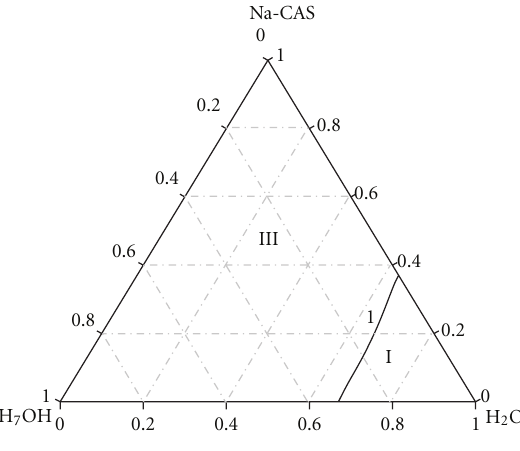
Figure 11: Solubility diagram of Na-CAS in water/isopropanol at 18 ◦